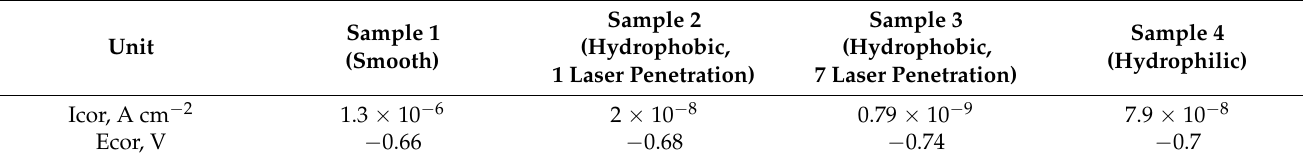
Table 4. Electrochemical parameters of the samples (samples correspond to Table